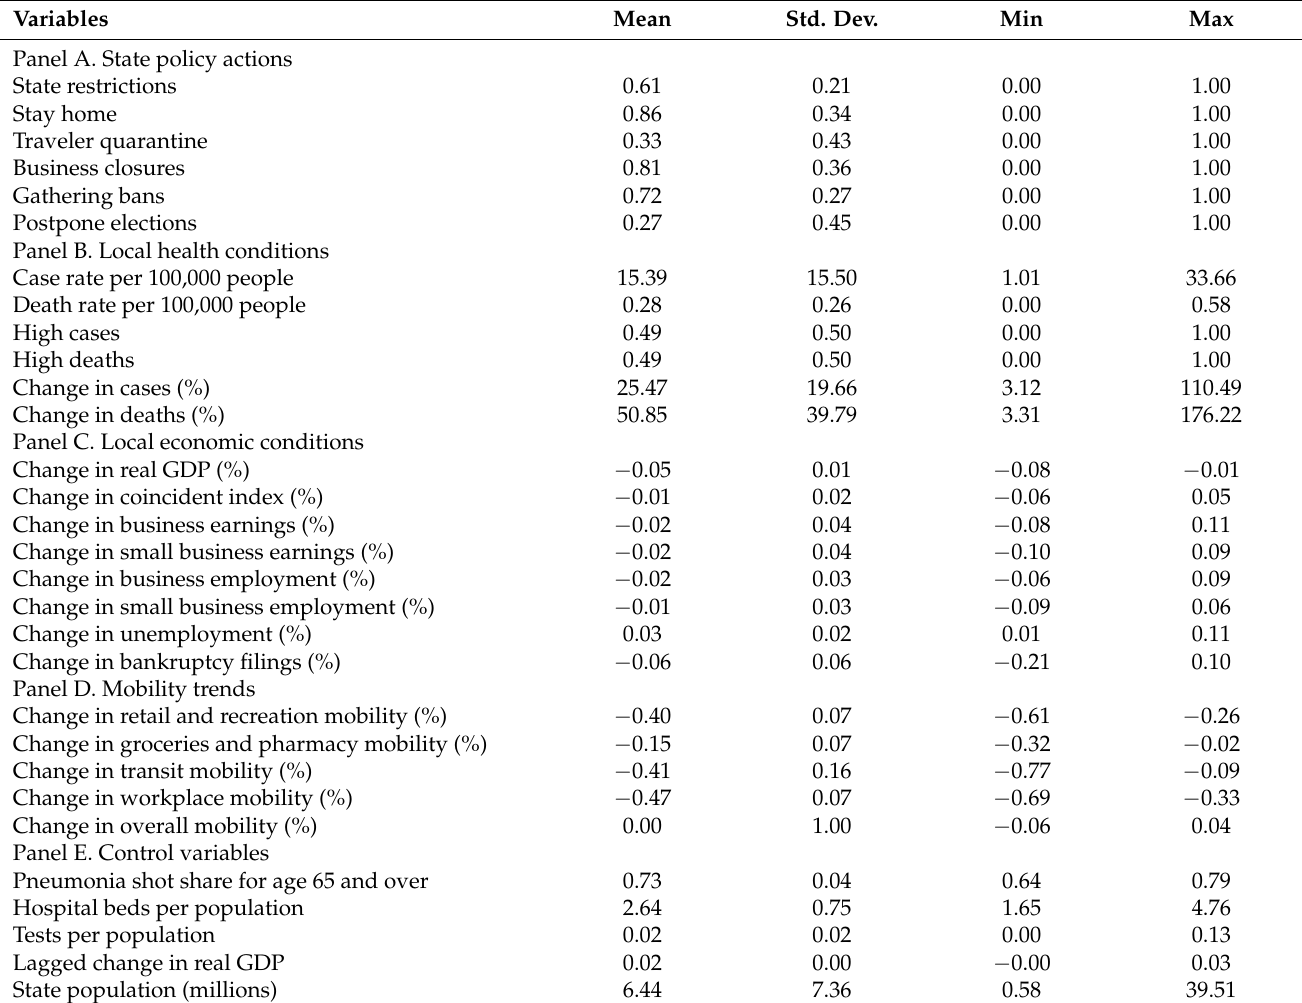
Table 1. Summary statistics. The table provides summary statistics of the variables used in the